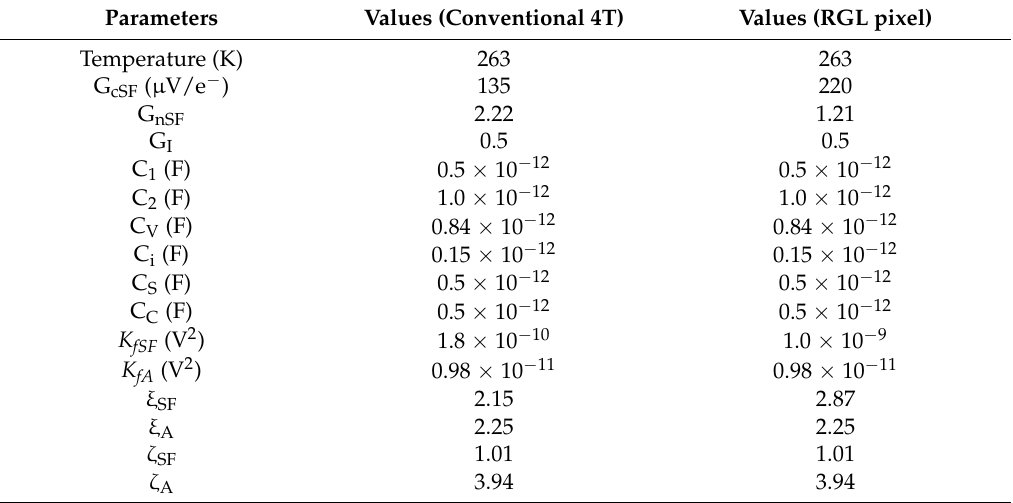
Figure 9. Noise components as a function of the sampling number in the CMS. Table 1. Device and circuit parameters used for noise